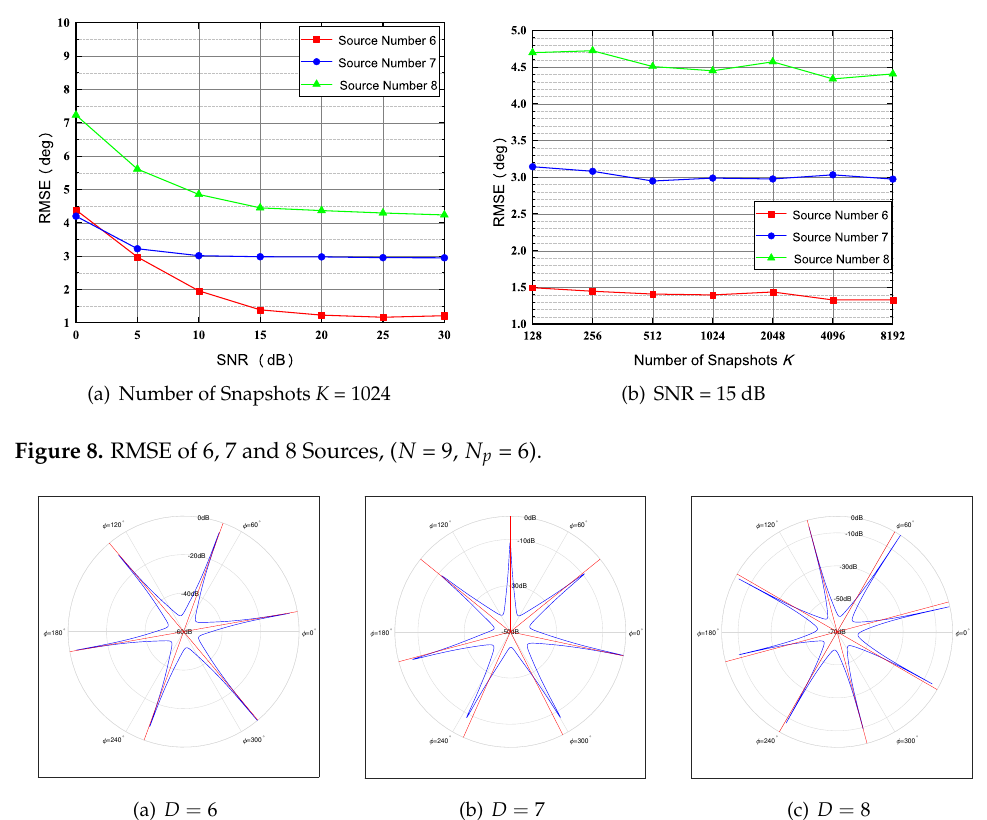
Figure 9. Normalized Spatial Spectrum of 6, 7 and 8 Sources, N = 9, N p = 6; (SNR = 10 dB, K = 1024).